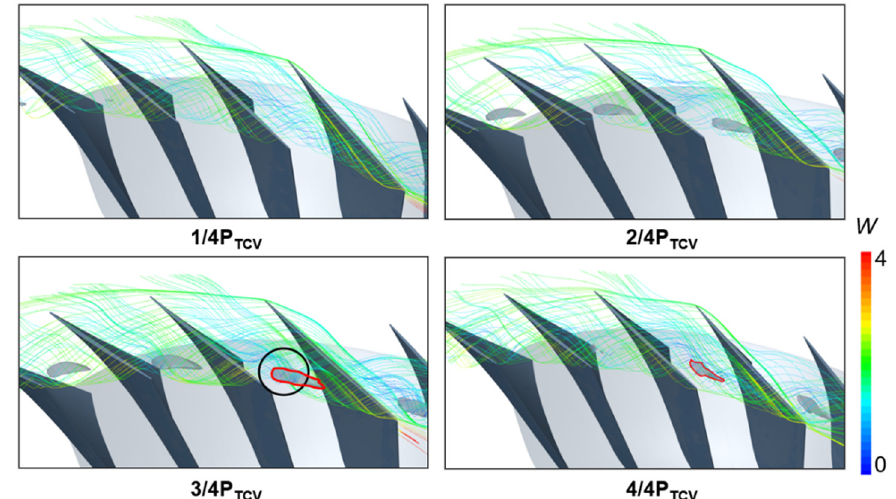
Figure 21. Unsteady streamlines from tip clearance with the iso-surface of Ma r = 0.2, P TCV is the period of the TCV (tip clearance vortex) shedding.